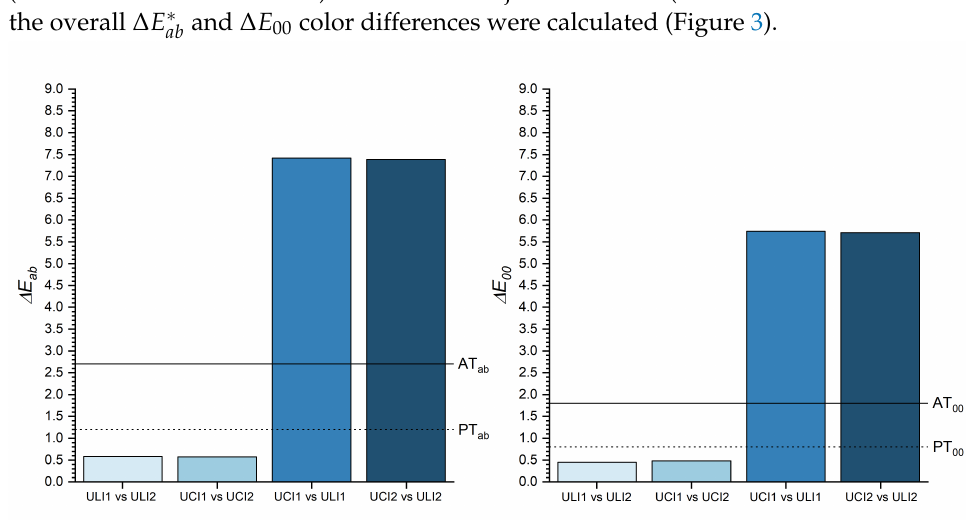
Figure 3. ∆ E ∗ and ∆ E 00 color differences between the contralateral and adjacent ab